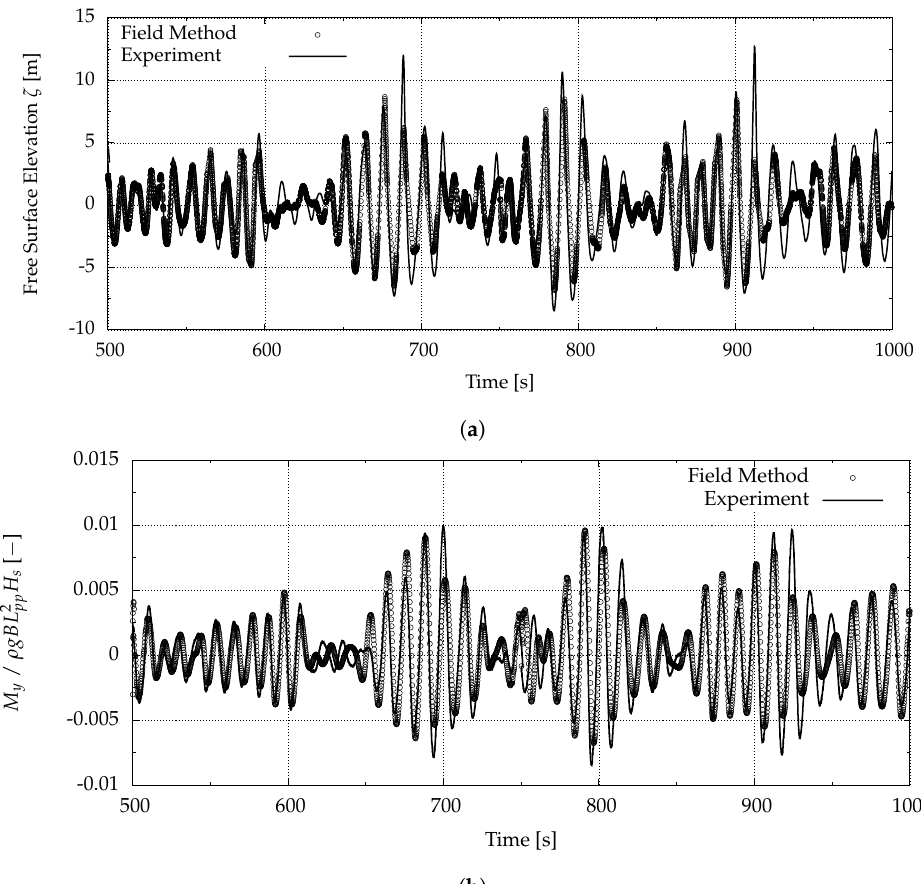
Figure 17. LNG carrier: field method computed and measured time histories of ( a ) free surface elevation and ( b ) midship vertical bending